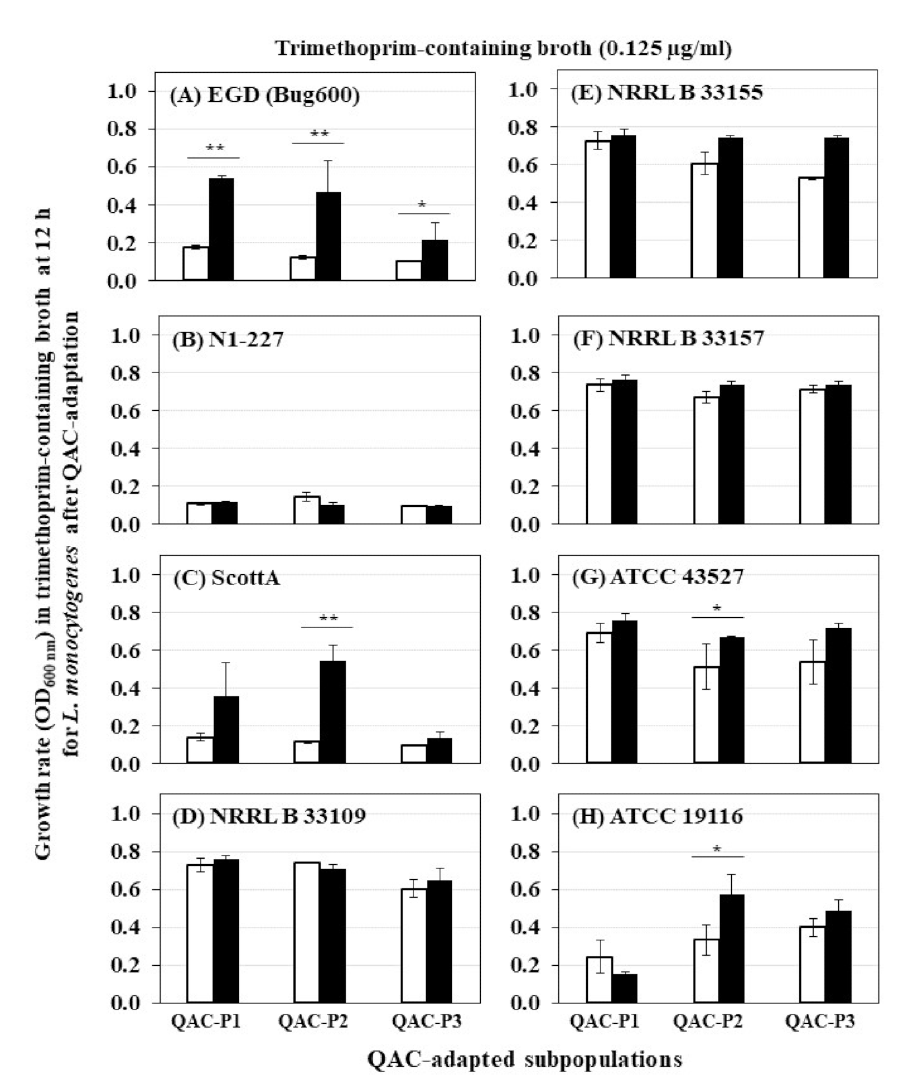
Figure 3. Changes in growth rate at 12 h (OD 600 ) in trimethoprim-containing broth of QAC-adapted subpopulations (closed bars) compared to non-adapted control (open bars) cells of eight L. monocy- togenes at 37 ◦ C: ( A ) EGD (Bug600), ( B ) N1-227, ( C ) ScottA, ( D ) NRRL B 33109, ( E ) NRRL B 33155, ( F ) NRRL B 33157, ( G ) ATCC 43527, ( H ) ATCC 19116. Error bars indicate standard errors of means. Statistically significant P values are indicated by asterisks (*, p < 0.05; **, p < 0.01) that were obtained using the unpaired two-tailed t